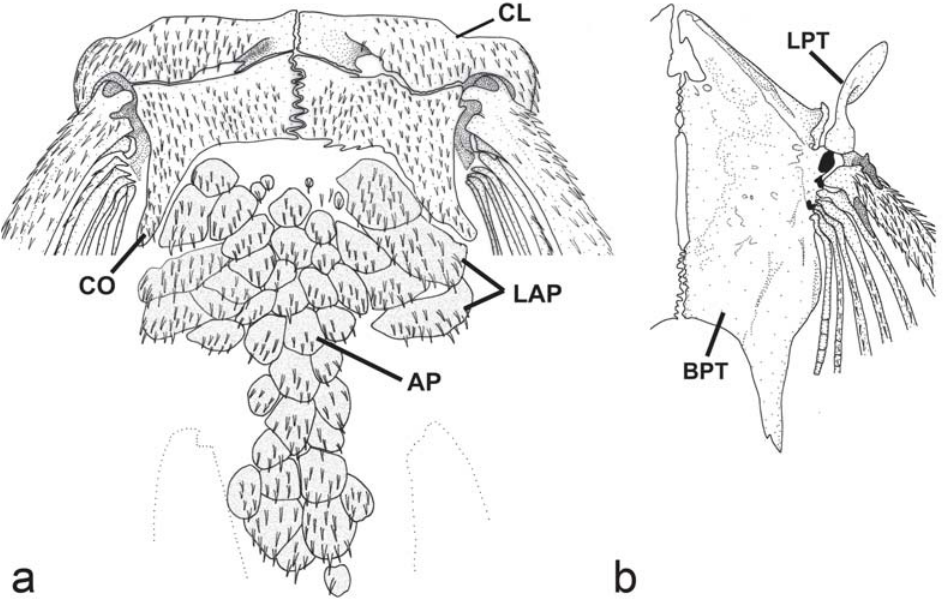
Fig. 4. Otothyropsis marapoama, paratype, LIRP 5641, 29.0 mm SL, a) pectoral girdle and abdominal platelets in ventral view, anterior to top; b) basipterygium in dorsal view, anterior to top.